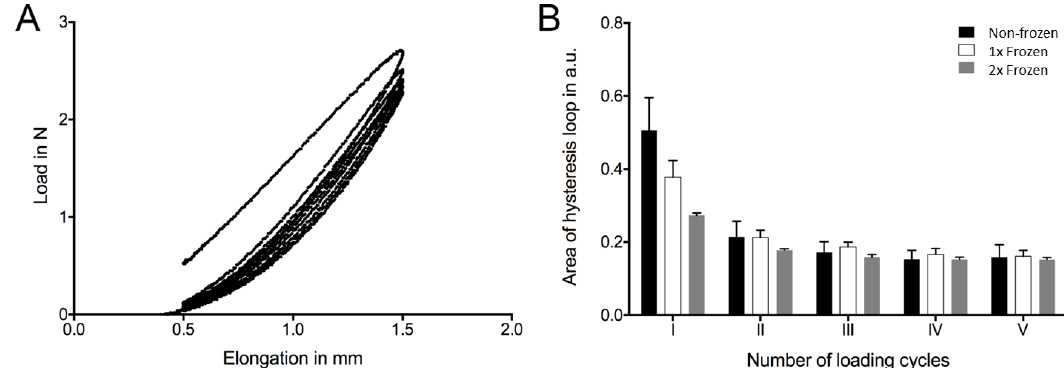
Figure 5. Assessment of the mechanical properties of the non-frozen, one-time frozen (1×), and two times frozen (2×) hAM. Representative hysteresis diagram of the hAM sample ( A ). The area of the hysteresis loop decreased with the increasing number of loading and unloading cycles. The